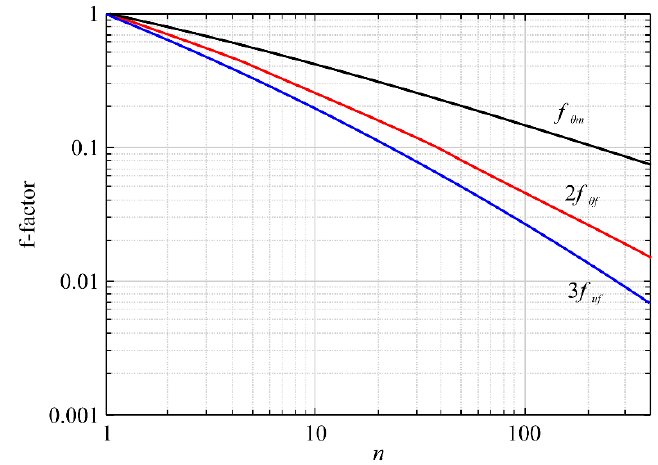
Figure 12. f -factors with variation of n ( = I 0 / I a Figure 12. f-factors with variation of n ( = 𝐼 (cid:2868) /𝐼 (cid:3028) )